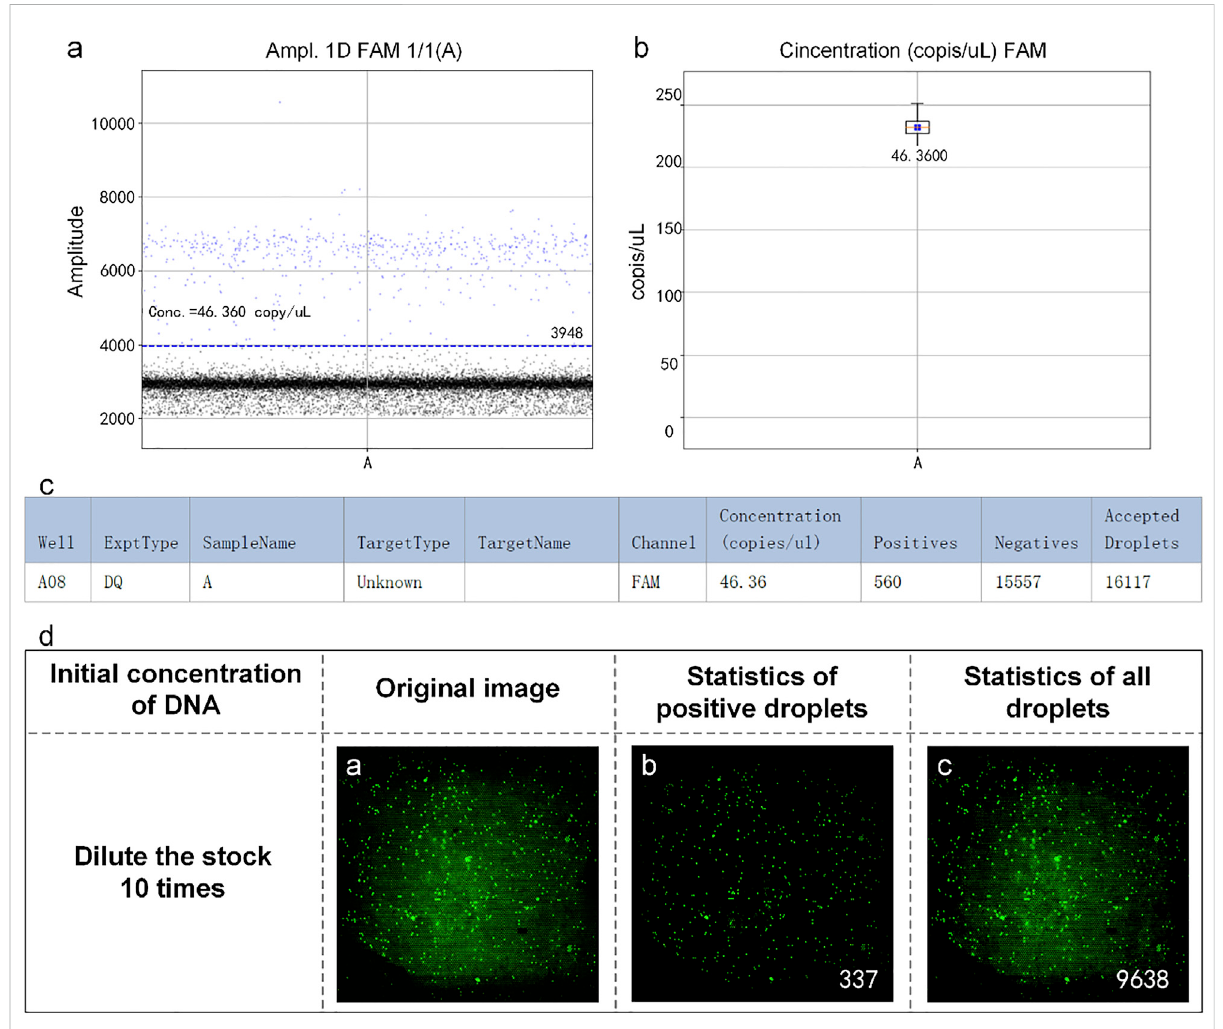
FIGURE 7 (A) Scatter plot by RainSure dPCR; (B) Initial DNA concentration calculated by RainSure dPCR; (C) Microdroplet data derived by RainSure dPCR; (D) Test results obtained with our